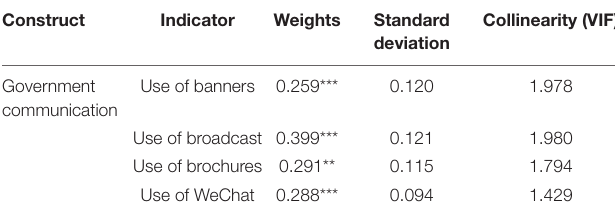
TABLE 4 | Assessment of formative